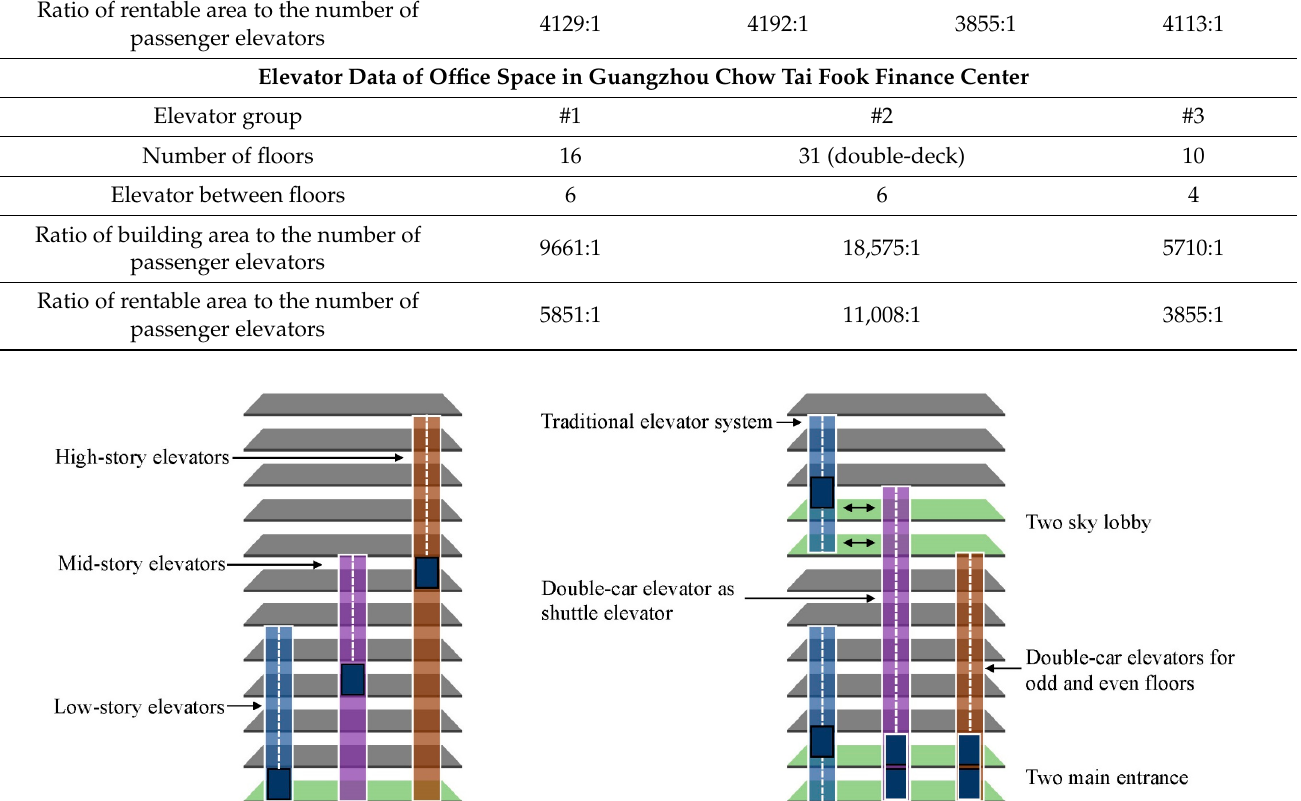
Figure 16. Schematic diagram of single and double-deck elevator system.